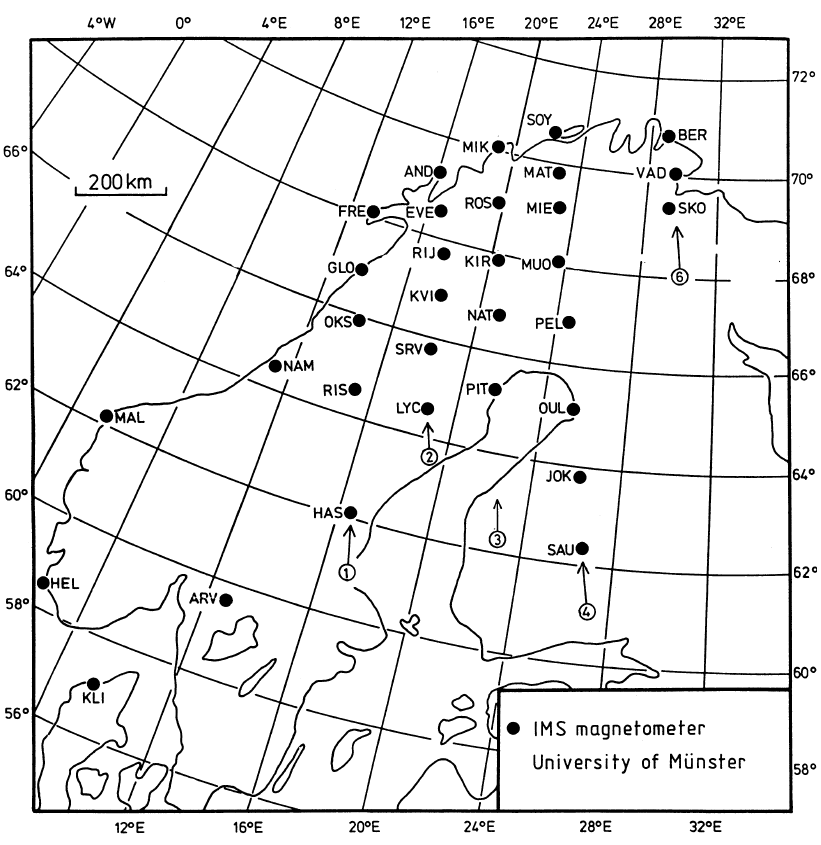
Fig. 1. Locations of the magnetometer stations of the Scandinavian magnetome- ter array in geographic coordinates. En- circled numbers with arrows denote di(cid:128)erent N-S profiles (after Ku¨ ppers et al. ,